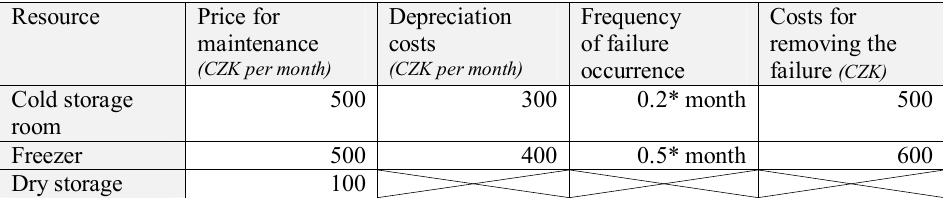
Depreciation costs (CZK per month)